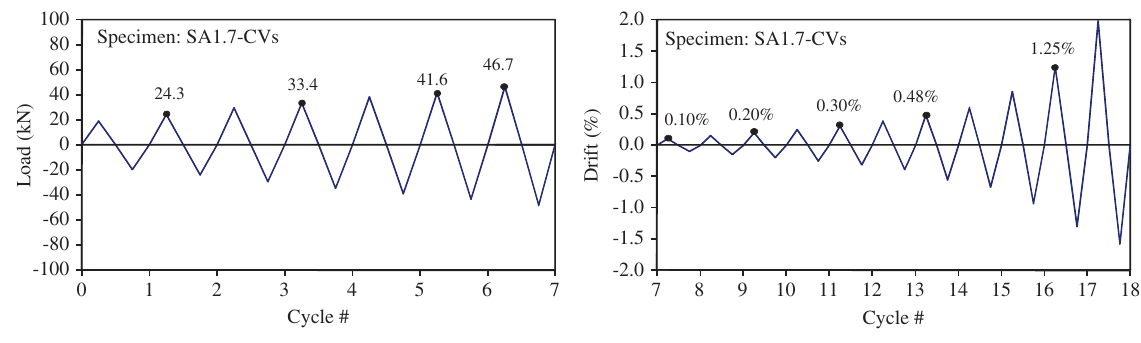
Figure 8 Loading regime for specimen